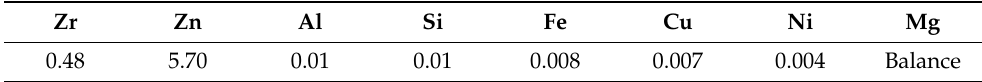
Table 1. Chemical composition (in wt %) of ZK60 magnesium